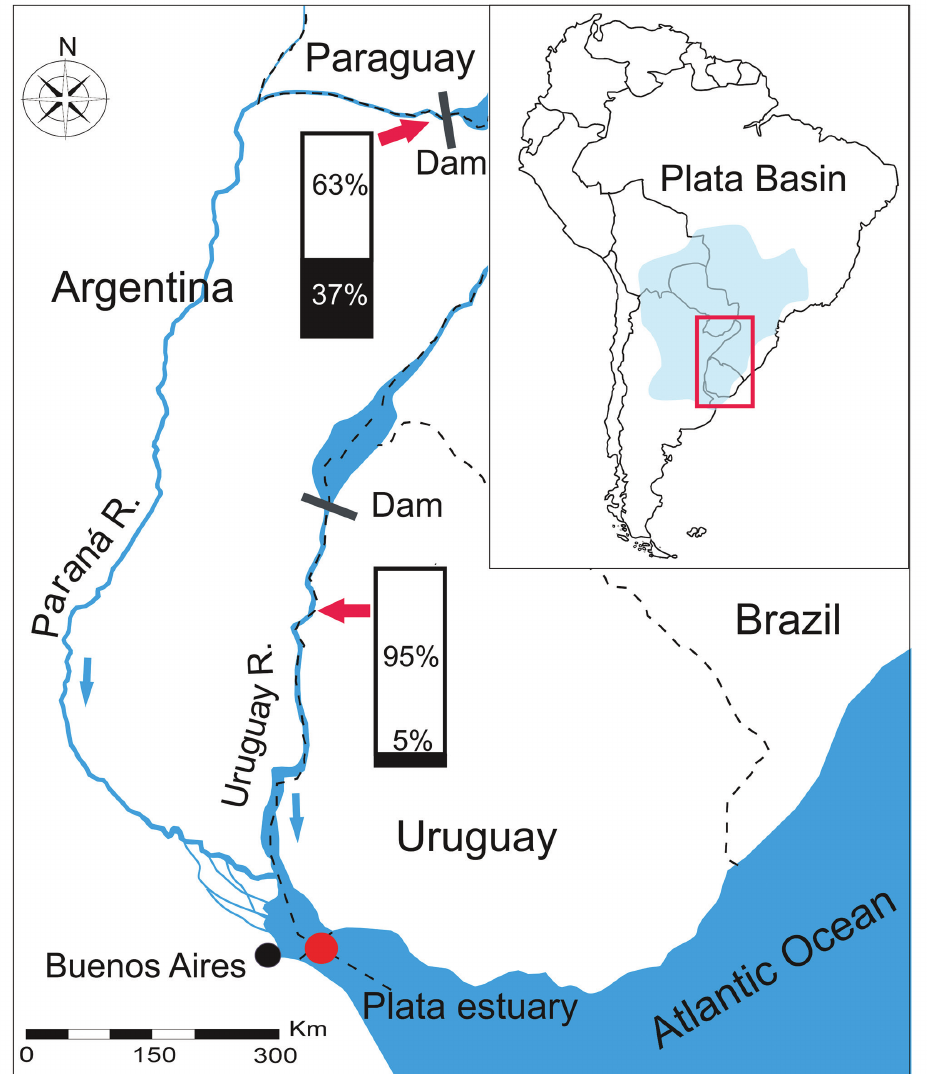
Fig. 1. Sampling sites of Prochilodus lineatus (red arrows). Red point shows the sampling site of fish use for transition threshold estimation between freshwater and brackish environments. The bar charts show the proportion of each migratory pattern for each collection site (black: freshwater straggler; white, freshwater